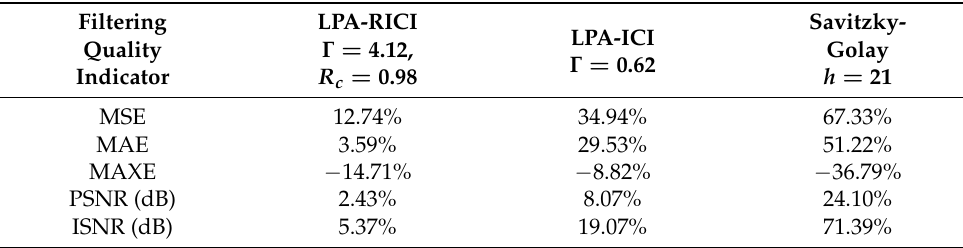
Table 5. Blocks signal (SNR = 7 dB)—Filtering quality improvement of the RBF-RICI-based filtering over other tested algorithms.